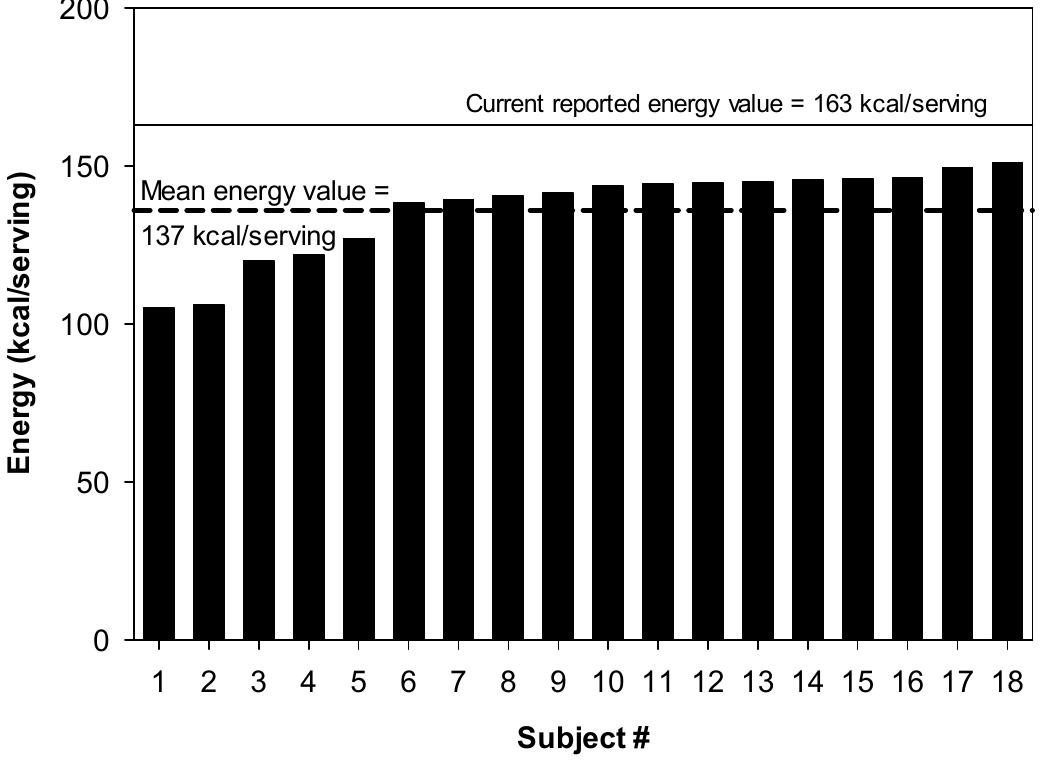
Figure 3. Energy value of cashew nuts. The dash line indicates the measured mean metabolizable energy value of 128.4 g serving of cashews. The solid line indicates the current value of cashews calculated using Atwater factors [16]. Subject # indicates data from an individual subject; each subject number indicates a different individual.